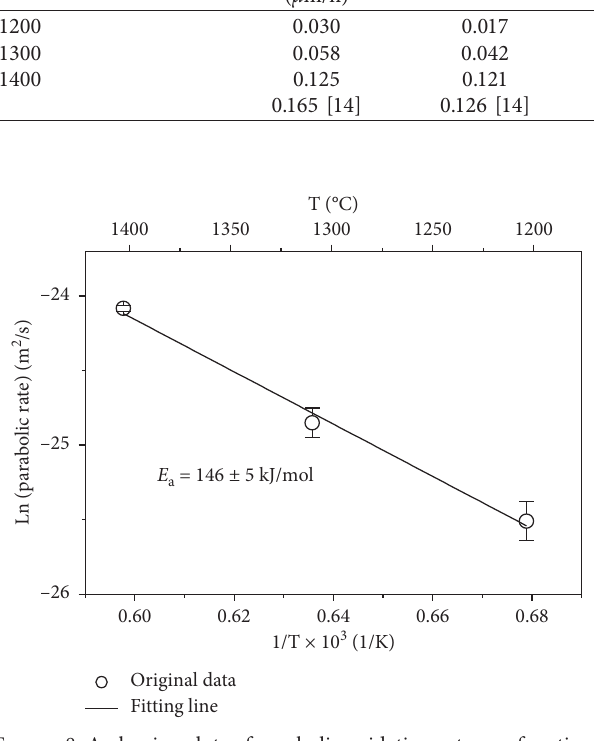
Figure 8: Arrhenius plots of parabolic oxidation rate as a function of temperature for the SiC layer oxidation in air